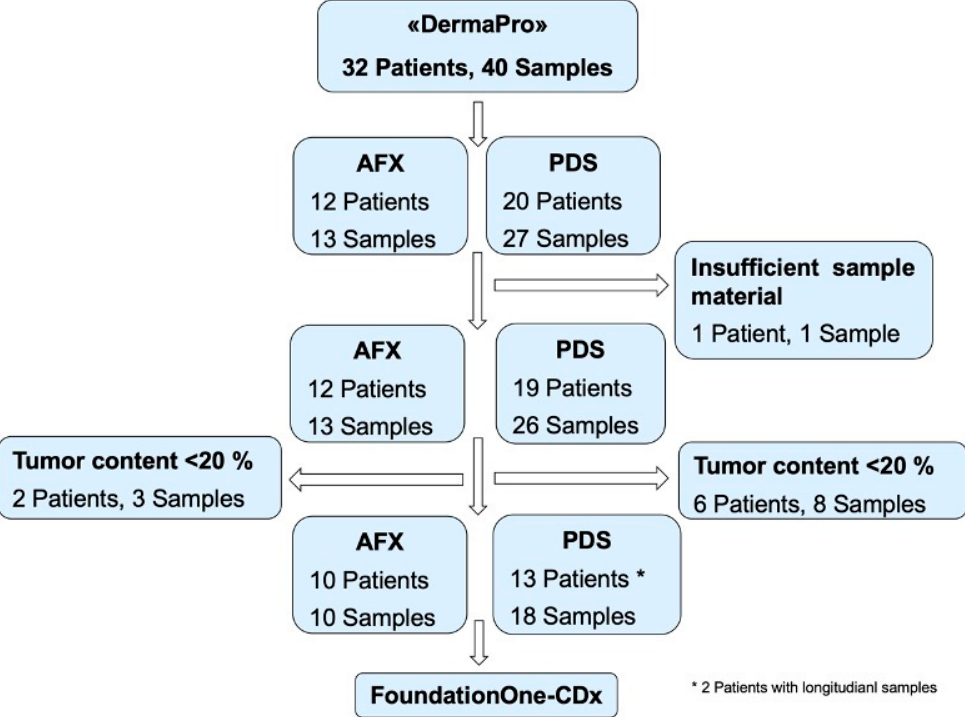
Figure 1. Representative flowchart of inclusion and exclusion of patients and samples. * 2 Patients with longitudinal sam- ples.